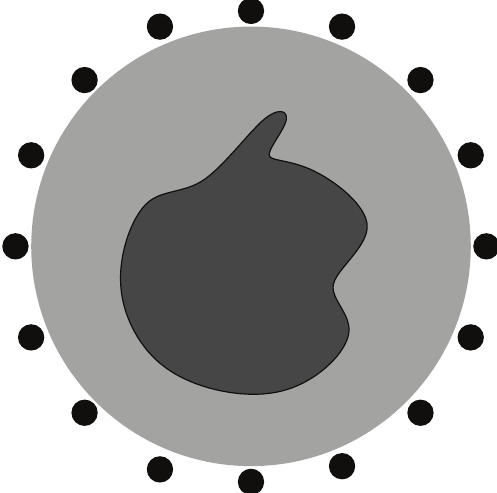
Figure 1: Schematic of the measurement system and simulation setup. The black dots indicate the positions of the antennas which are positioned in a circle with a radius of 7 . 62cm. The light-gray area illustrates the circular imaging domain with a radius of 7 . 25cm in which the object to be imaged (dark-gray area) is completely enclosed.